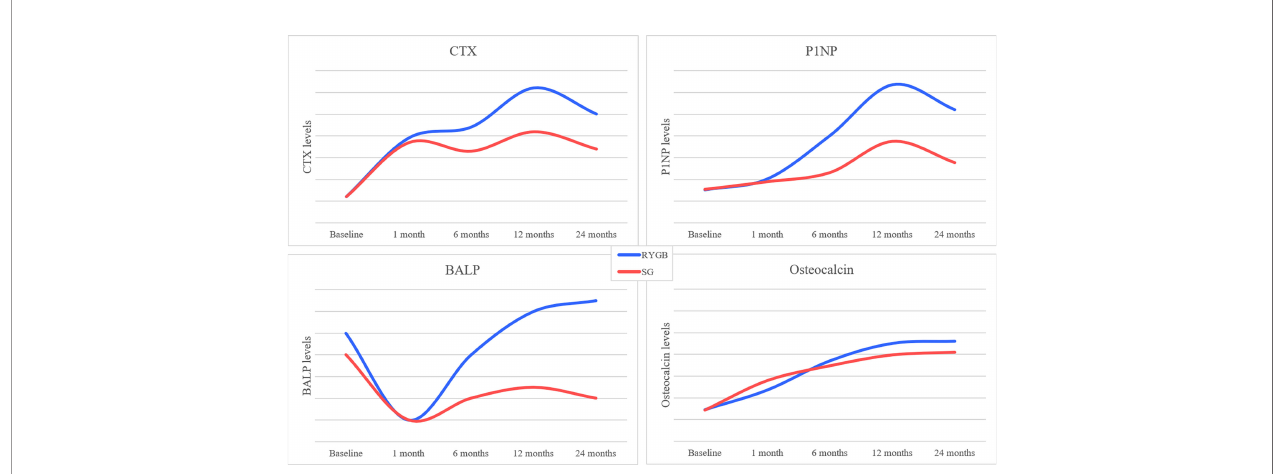
FIGURE 2 | Visual graph of changes over time of bone turnover markers levels after bariatric surgery procedures (RYGB and SG). Data extracted from the references (116,